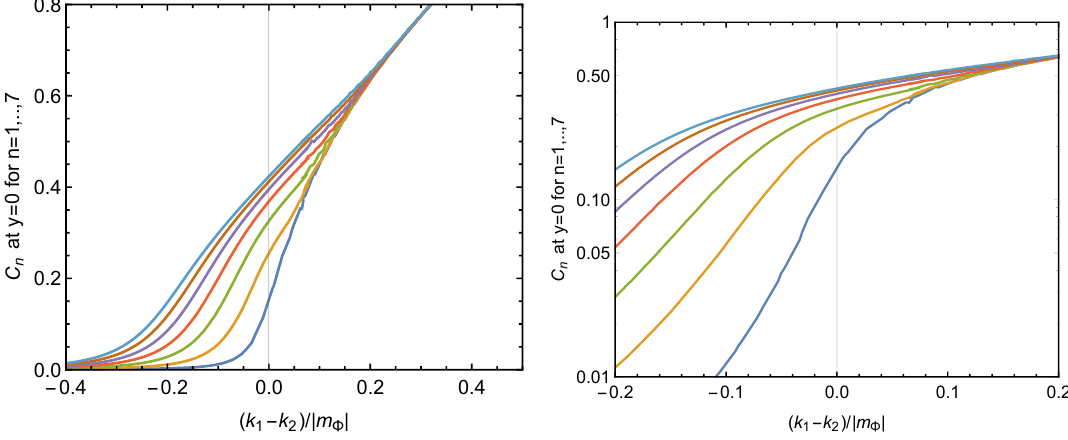
Figure 3 . The couplings between the boundary localized (cid:12)elds (at y = 0) and the KK modes ( n = 1 ; 2 ; (cid:1) (cid:1) (cid:1) ; 7) as a function of (cid:20)= j m (cid:8) j (cid:17) ( k 1 (cid:0) k 2 ) = j m (cid:8) j for (cid:12)xed value of m (cid:8) and R . where C ( y ) is determined to n b